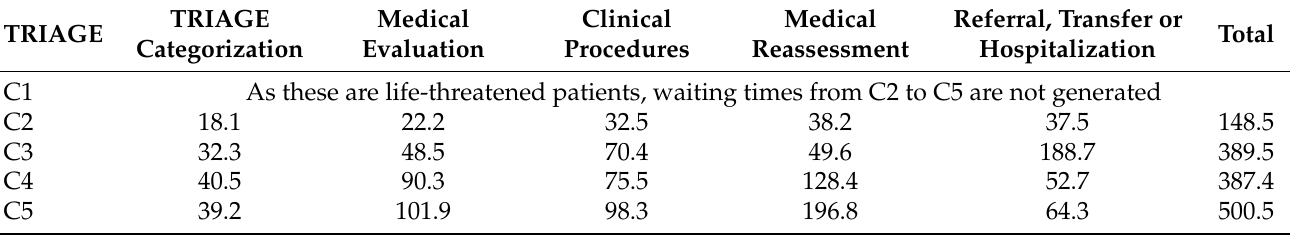
Table 3. Average waiting times for patients attending an Emergency Department (Average time in minutes). TRIAGE